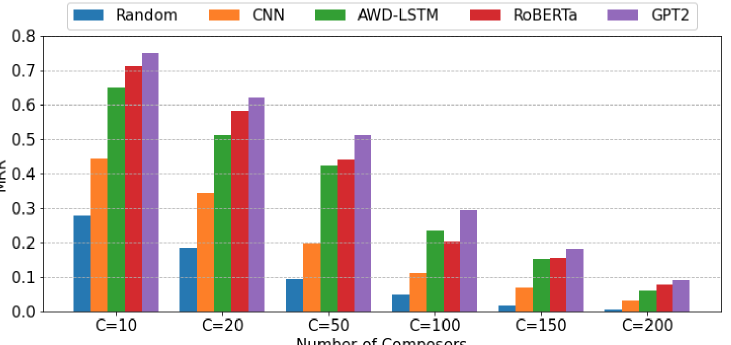
Figure 10. Comparison of models on a ranking task involving unseen composers. C composers are randomly selected from IMSLP (excluding the original 9 composers in the labeled dataset), each page of piano sheet music for these C composers is considered as a query, and the KNN distance (excluding pages from the same piece) is used to rank the C composers. From left to right, the bars in each group correspond to random guessing, CNN, AWD-LSTM, RoBERTa, and GPT-2 models. Each bar shows the average of 10 such